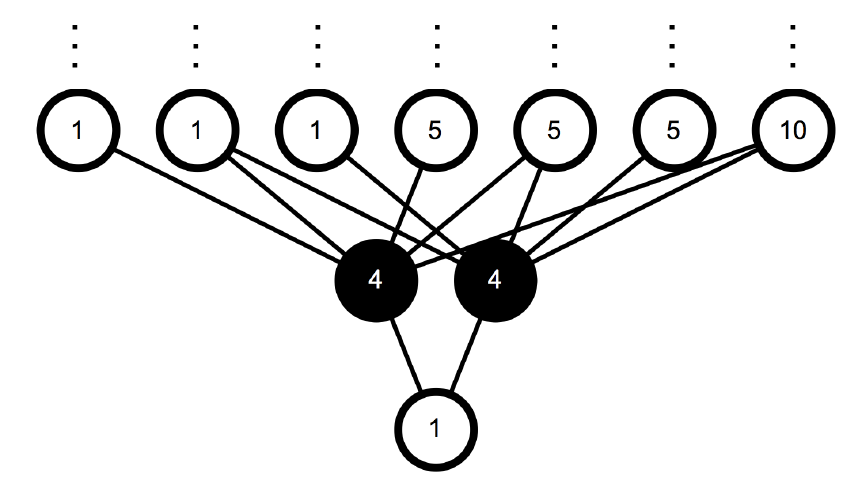
Figure 16 . Adinkra Diagram for 5D minimal scalar